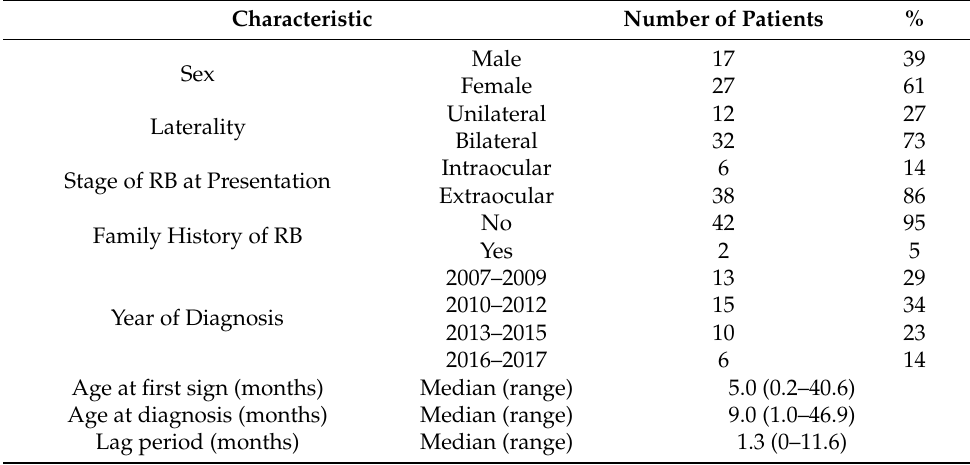
Table 1. Clinical characteristics of 44 patients who refused any treatment.